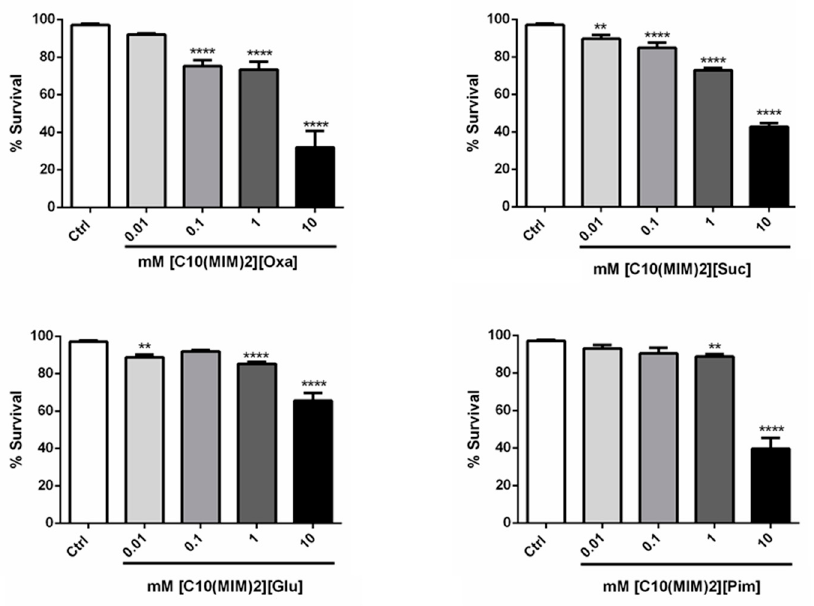
Figure 5. Survival assay for wild-type (N2) worms in C 10 (MIM) 2 [Oxa], C 10 (MIM) 2 [Suc], and C 10 (MIM) 2 [Oxa] C 10 (MIM) 2 [Pim]. ** p < 0.01 and **** p < 0.0001 compared to Ctrl